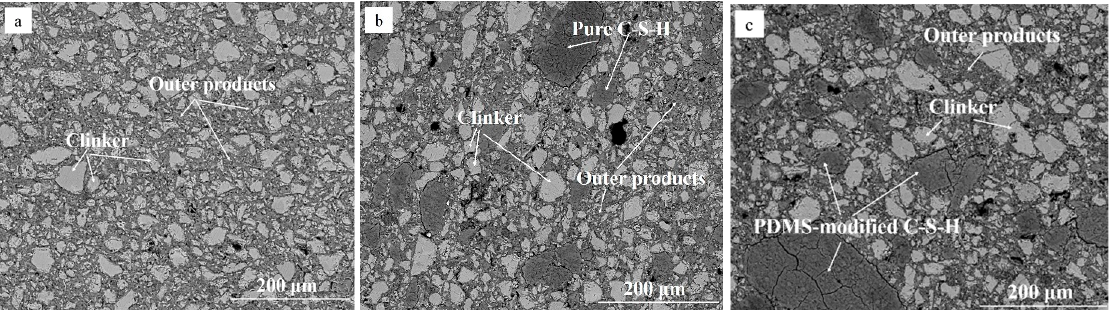
Figure 3. BSE images of MDF cement containing: ( a ) 0% C-S-H powders; ( b ) 5% PDMCSH00; ( c ) 5% PDMCSH50.